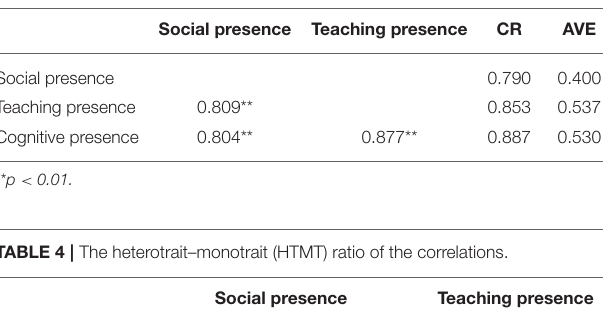
TABLE 5 | The statistical analysis of each CoI measurement dimension between males and females.